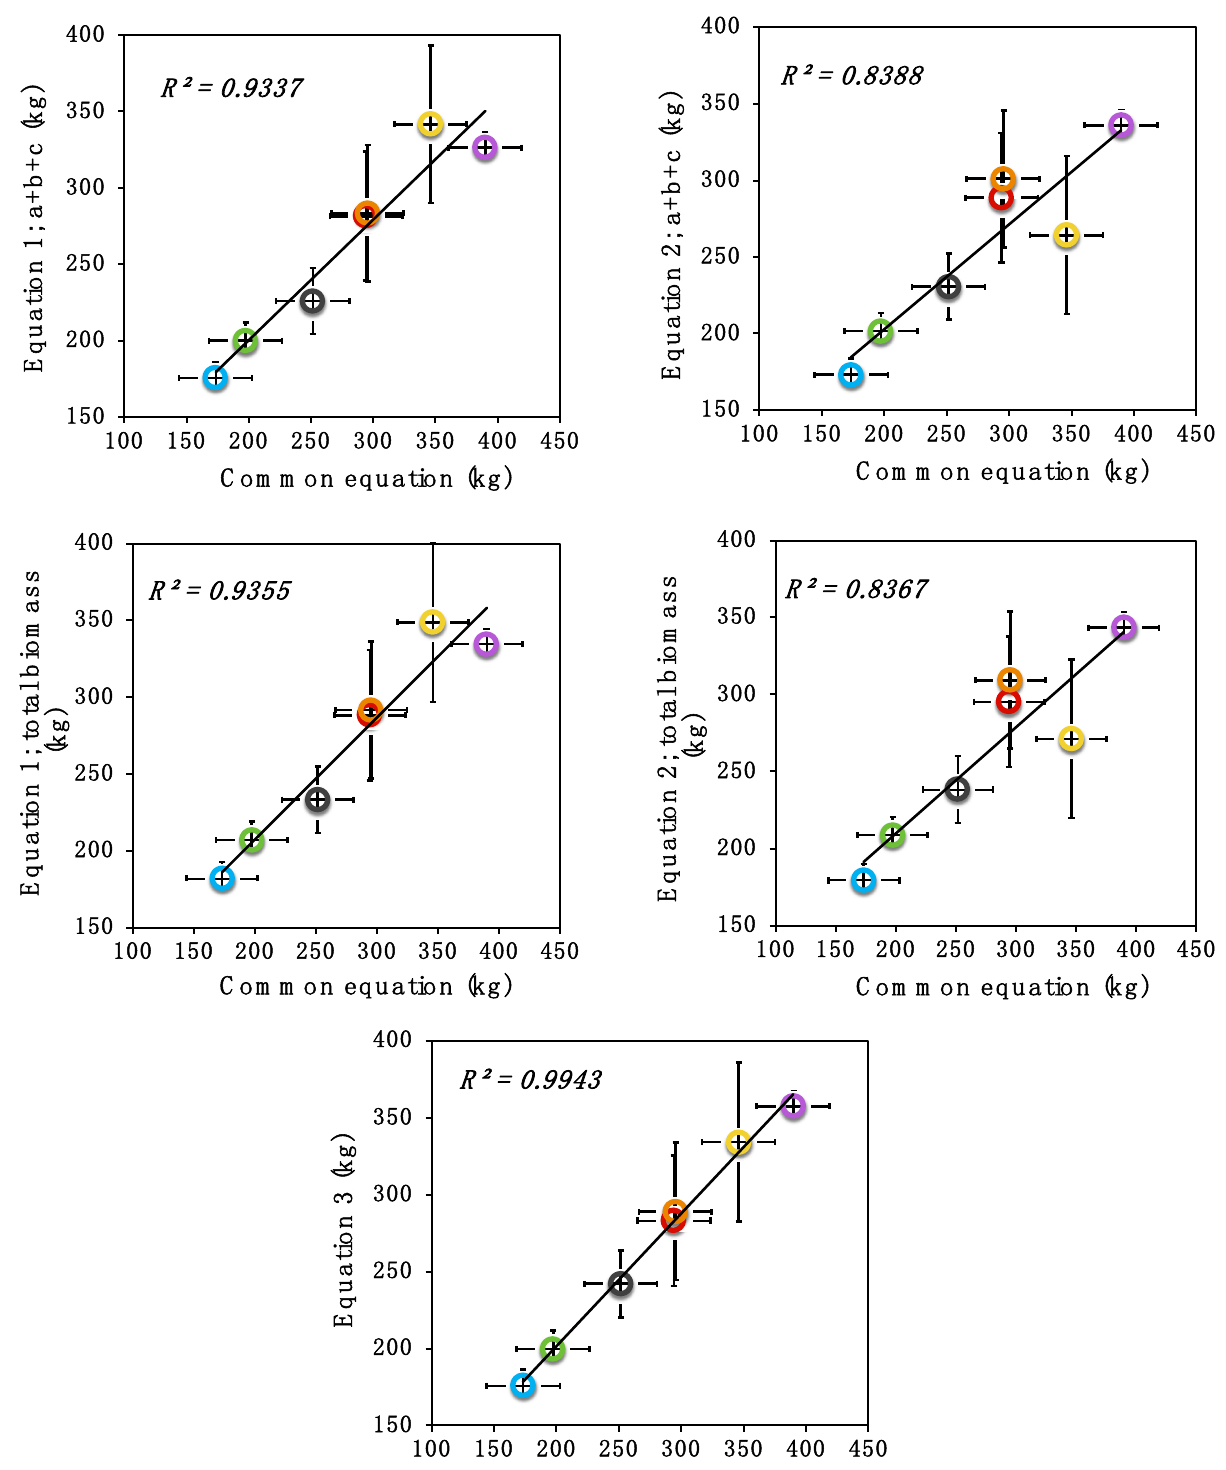
Figure 5. Five developed equations of aboveground biomass (kg) estimation of 1000 standing trees regarding species in the 1 ha plot inventory of Sungai Pulai Forest Reserve. Blue: B. cylindrica , red: B. parviflora ; green: B. sexangula ; orange: C. tagal ; purple: R. apiculata ; dark grey: R. mucronata ; and yellow: X. granatum.